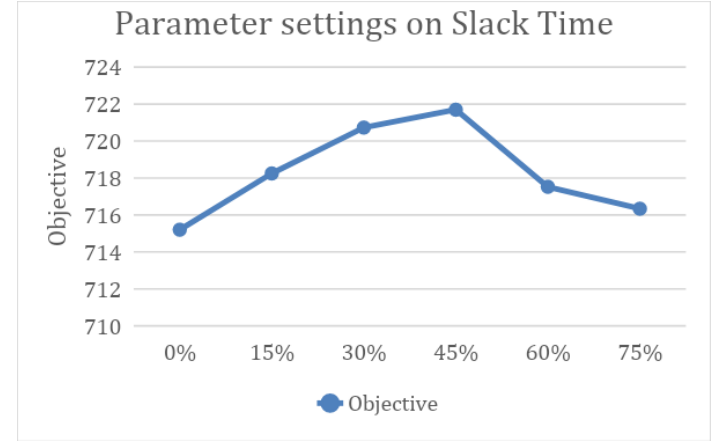
Figure 6. Parameter settings on slack time.